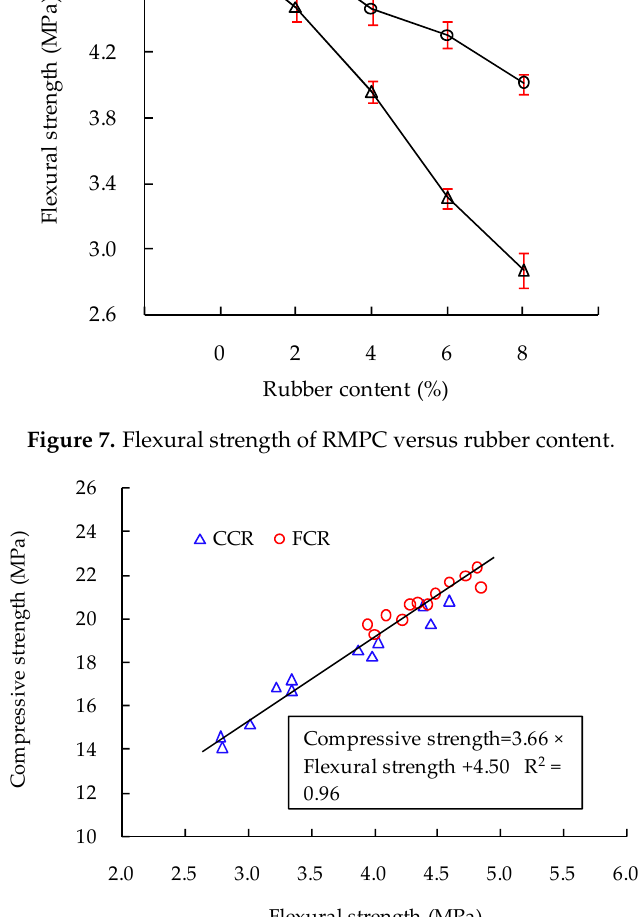
Figure 9. Flexural strain of RMPC versus rubber content.